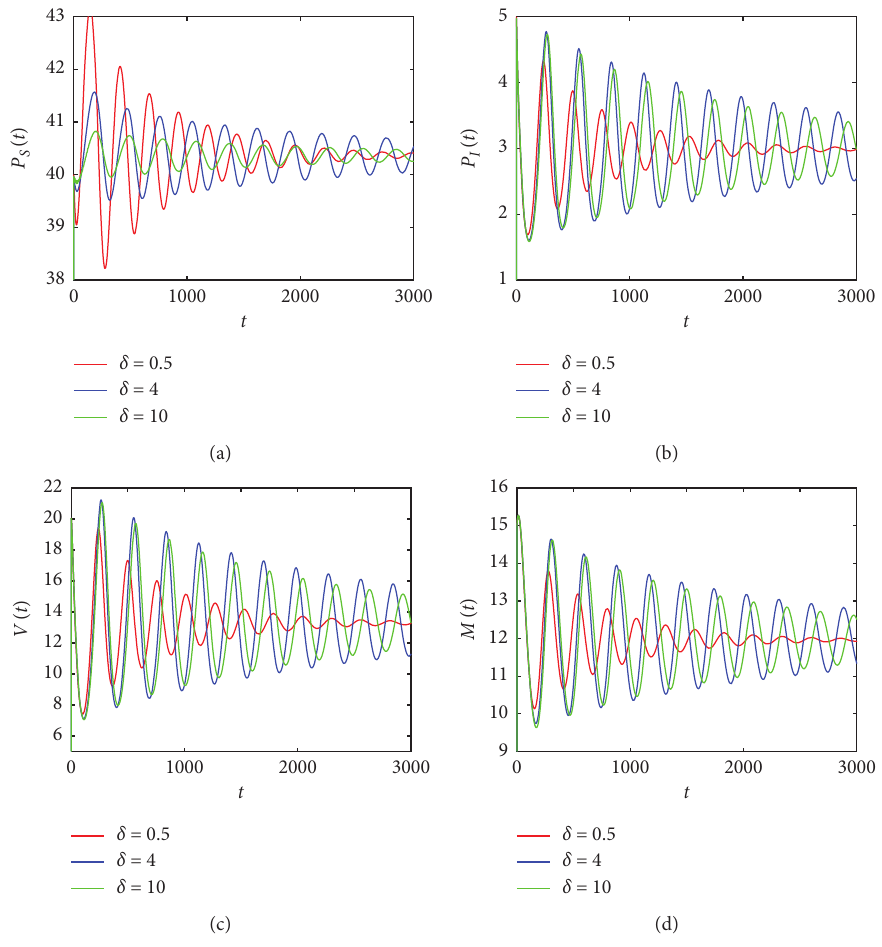
Figure 12: The time series of system (5) when α � 0.98, k � − 2, δ � 0 . 5, δ � 4, δ � 10, and τ � 30.